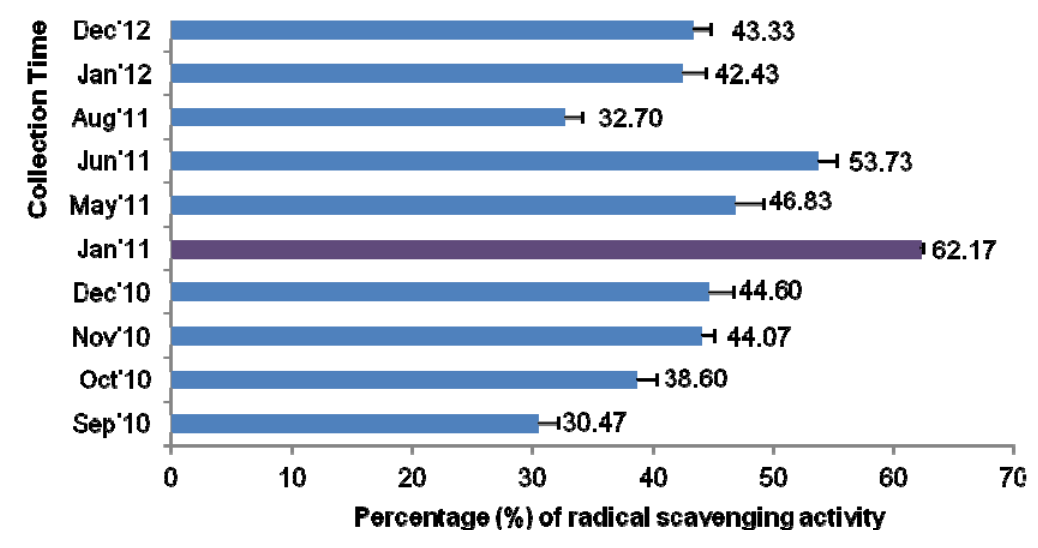
Figure 5. DPPH radical scavenging activities of the Malaysian acacia